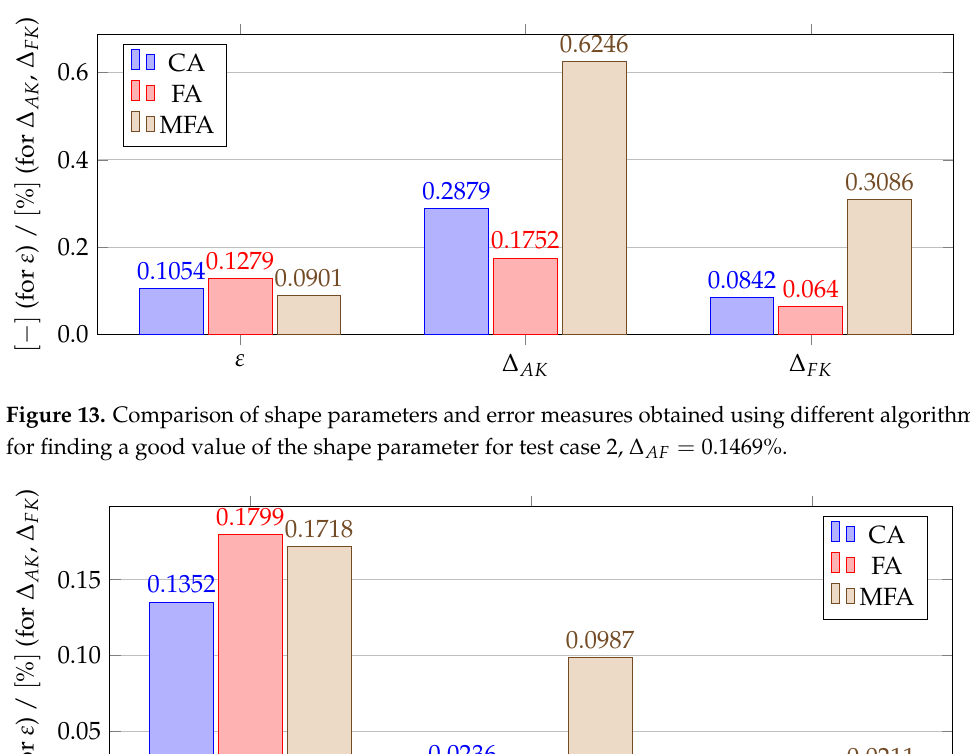
Figure 12. Comparison of shape parameters and error measures obtained using different algorithms for finding a good value of the shape parameter for test case 1, ∆ AF = 0.0674%.